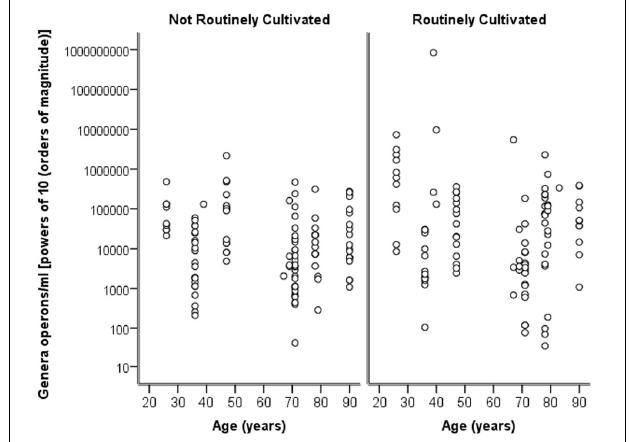
FIGURE 3 | Plot of total operons/ml per person (powers of 10—order of magnitude) for each genus that is cultivated routinely by standard microbiological testing, and those not routinely cultivated (including those not individually identified in routine culture).